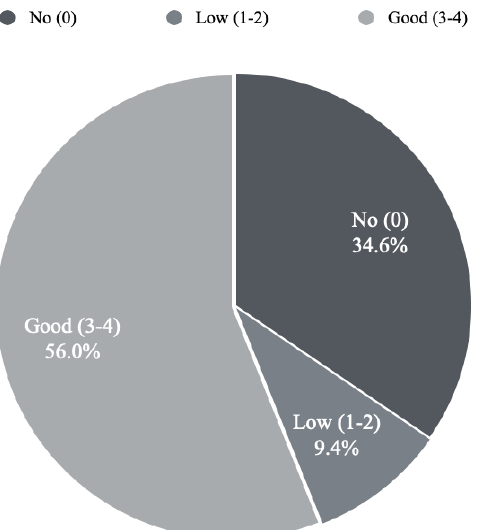
Figure 2. The knowledge of RFS among participants. Three levels of knowledge were measured. No knowledge, low, and good.